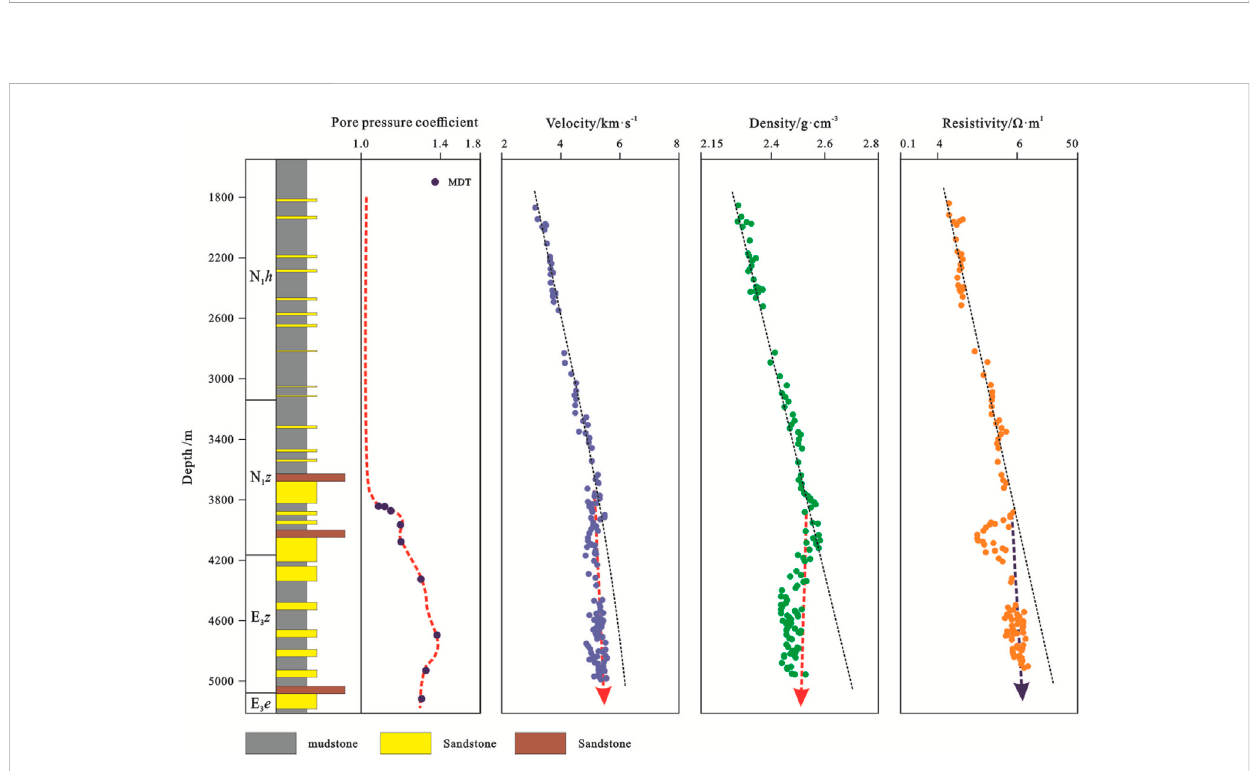
FIGURE 5 Calculation results of pore formation pressure and depth pro fi les of well-logging parameters, including velocity, density, resistivity and MDT data from Well BY02.